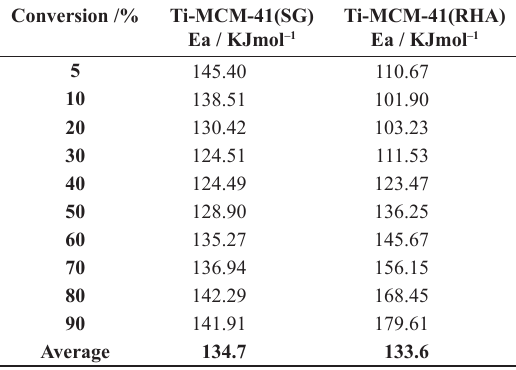
Table 1. Apparent activation energy for the conversion values (α) from 5 to